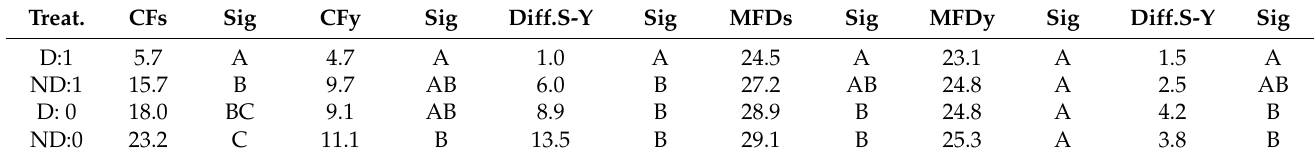
Table 2. The mean comparison of coarse fibre (CF) content (s: surface; y: yarn), fibre diameter (MFD) (s:y), and the difference between surface and yarn (Diff.S-Y), in relation to the interaction of dehairing (D; ND) per perception effects (0: non-sig.; 1: sig.).